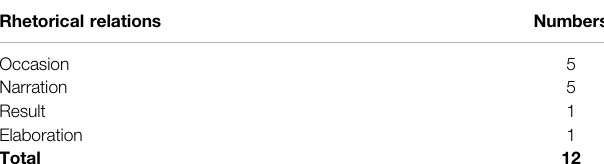
TABLE 5 | Rhetorical relations in the German